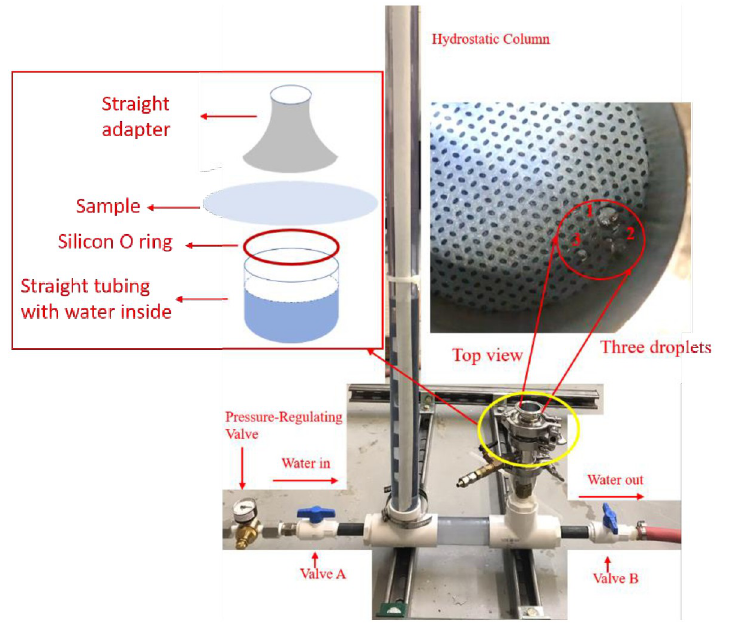
Fig 11. Hydrostatic pressure tester setup and top view of